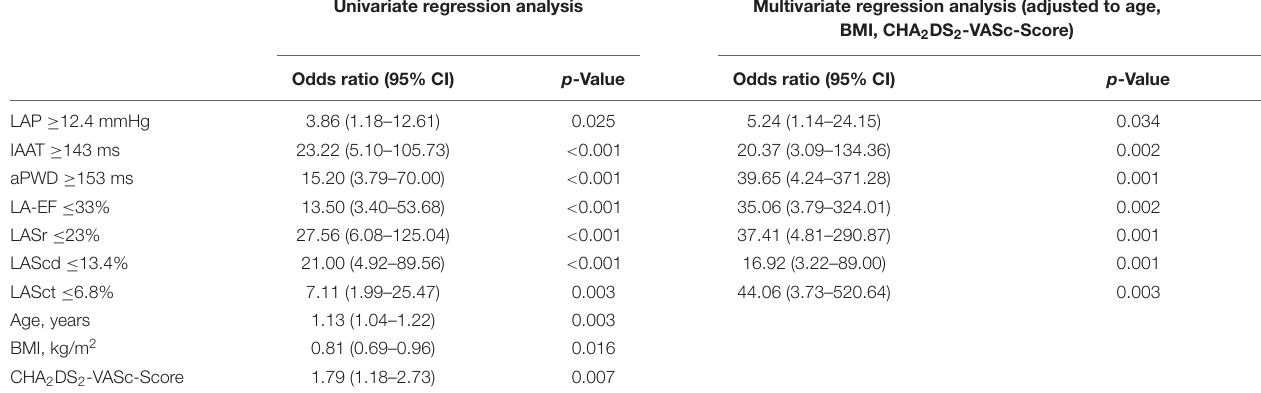
TABLE 2 | Predictors for atrial cardiomyopathy.